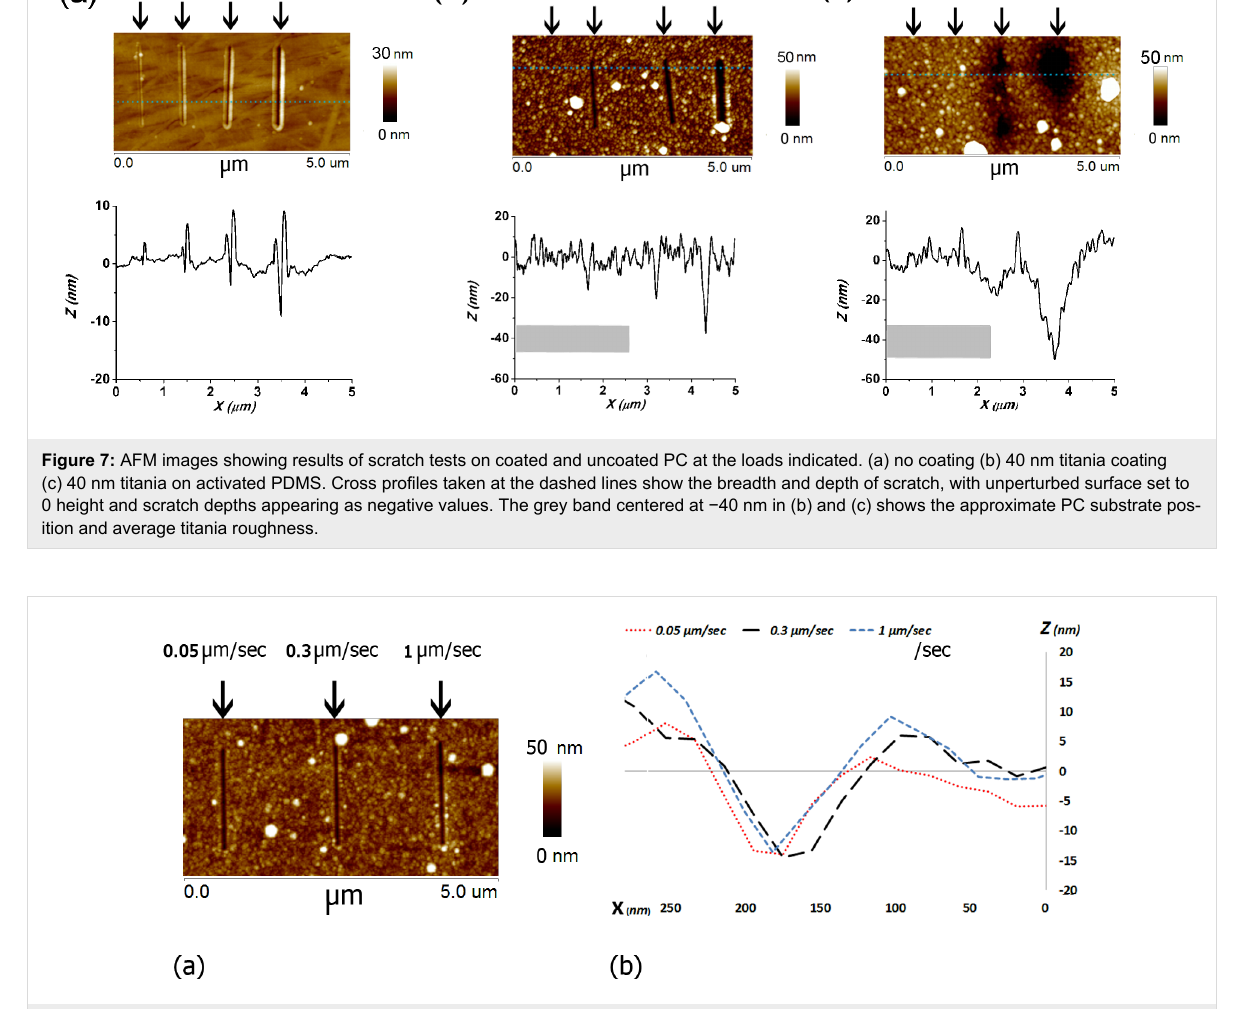
Figure 8: Dependence of scratch resistance on sliding speed. a) AFM image of PC + TiO 2 after scratching. b) Cross-sections of the scratches at three different velocities and constant load of 10